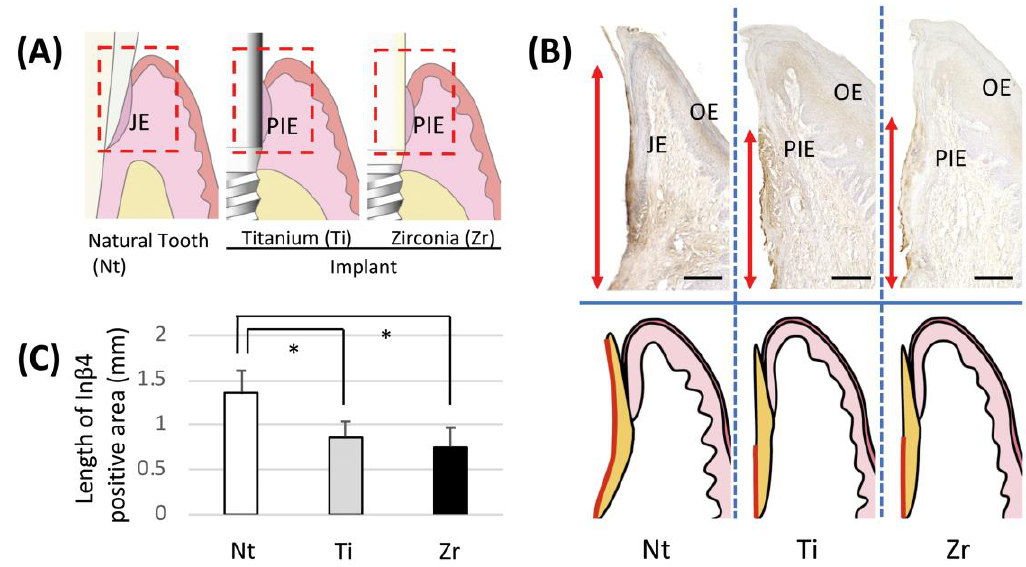
Figure 2. Immunohistochemical localization of integrin β 4 (In β 4) in junctional epithelium (JE) and peri-implant epithelium (PIE). ( A ) Schemes of periodontal and peri-implant structures. Dotted red line indicates observed area. ( B ) Immunohistochemical localization of In β 4 in JE or PIE around natural tooth (Nt) or implants with titanium (Ti) or zirconia (Zr) transgingival insert. Schematic diagrams of soft tissue structures around teeth or implants shown in lower panels. Red arrows (upper panel) and lines (lower panel) indicate range of In β 4-positive area; bar = 200 µ m. ( C ) Mean In β 4 subunit-positive lengths on JE or PIE around Nt, Ti and Zr. Data represent means ± SD of three parallel experiments. * p < 0.05.